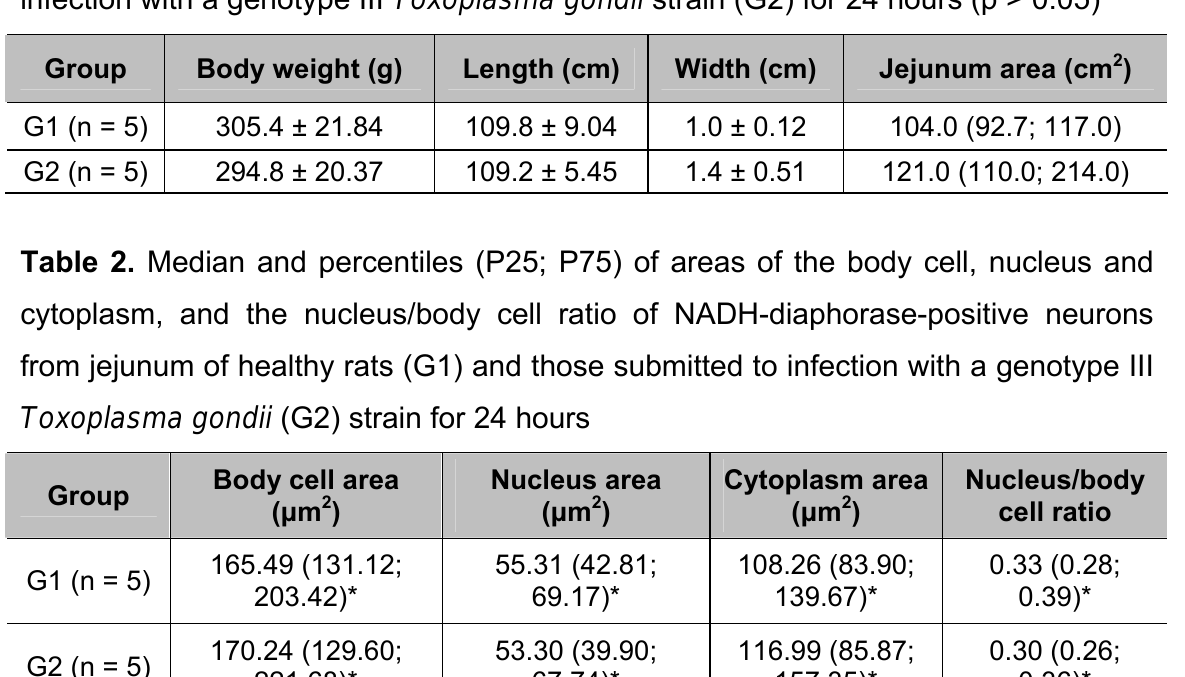
Table 1. Mean and standard deviation of body weight, length and width; median and percentiles (P25; P75) of jejunum area in healthy rats (G1) and those submitted to infection with a genotype III Toxoplasma gondii strain (G2) for 24 hours (p > 0.05)